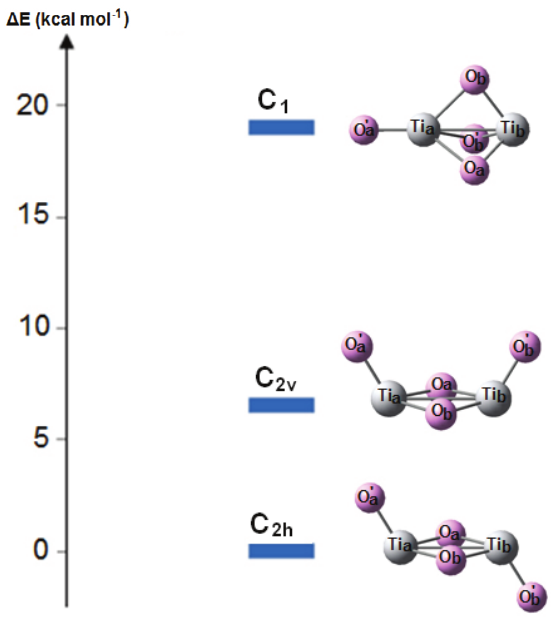
Figure 2 . Energy diagram of the studied isomers relatively to the energy of the T-Ti